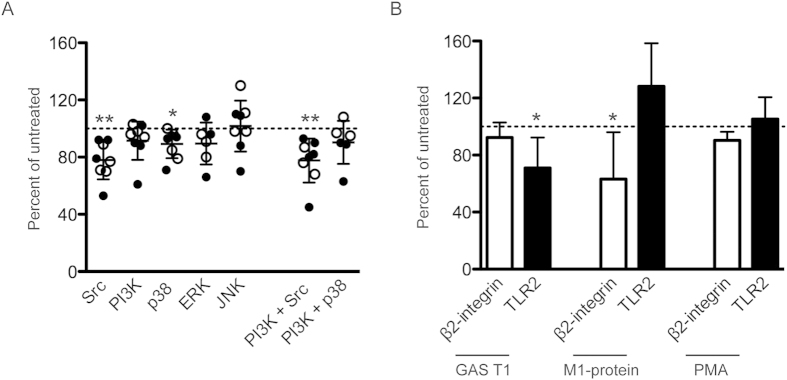
Signalling molecules and receptors involved in the release of resistin.Resistin levels in cell culture supernatants of neutrophils from healthy donors, pre-treated for 30 min with inhibitors targeting the signalling molecules Src (PP1), PI3K (LY294002), MAPK p38 (SB203580), ERK (PD98059), and JNK (SP600125) (A) or antibodies against β2-integrins (anti-human CD18) and TLR-2 (anti-Human CD282) (B), and stimulated with fixed GAS for 2 h. In A, open and filled symbols show 5448 and the T1 isolate, respectively. Mean ± SD of results from 3–9 experiments using different donors presented as per cent relative to untreated cells, the dashed line indicates 100 per cent. The inhibitors did not influence the cell response, as unstimulated cells had similar background levels in the presence or absence of the inhibitors. Wilcoxon matched-pairs signed rank test was used for comparison between groups, *P > 0.05,**P < 0.01.